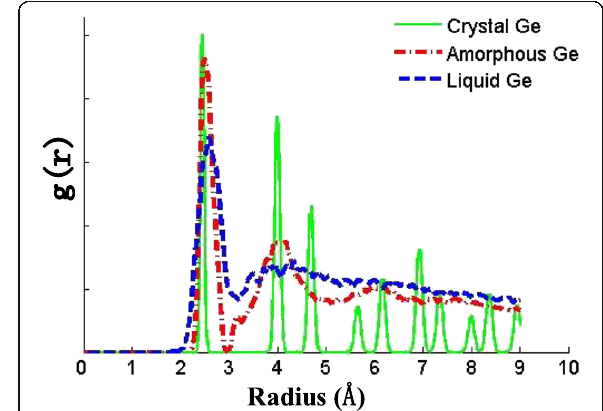
Fig. 4 Radial distribution function (RDF) of the monocrystalline, liquid, and amorphous